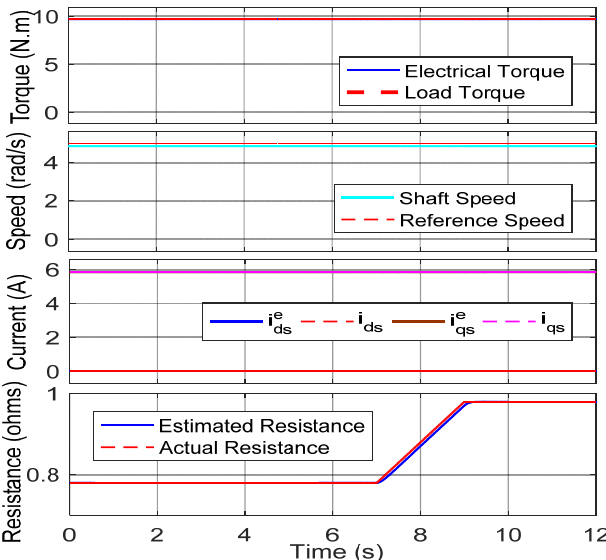
Figure 9 . The drive was tested for the online stator-resistance estimation and compensation. Figure 9. The drive was tested for the online stator-resistance estimation and